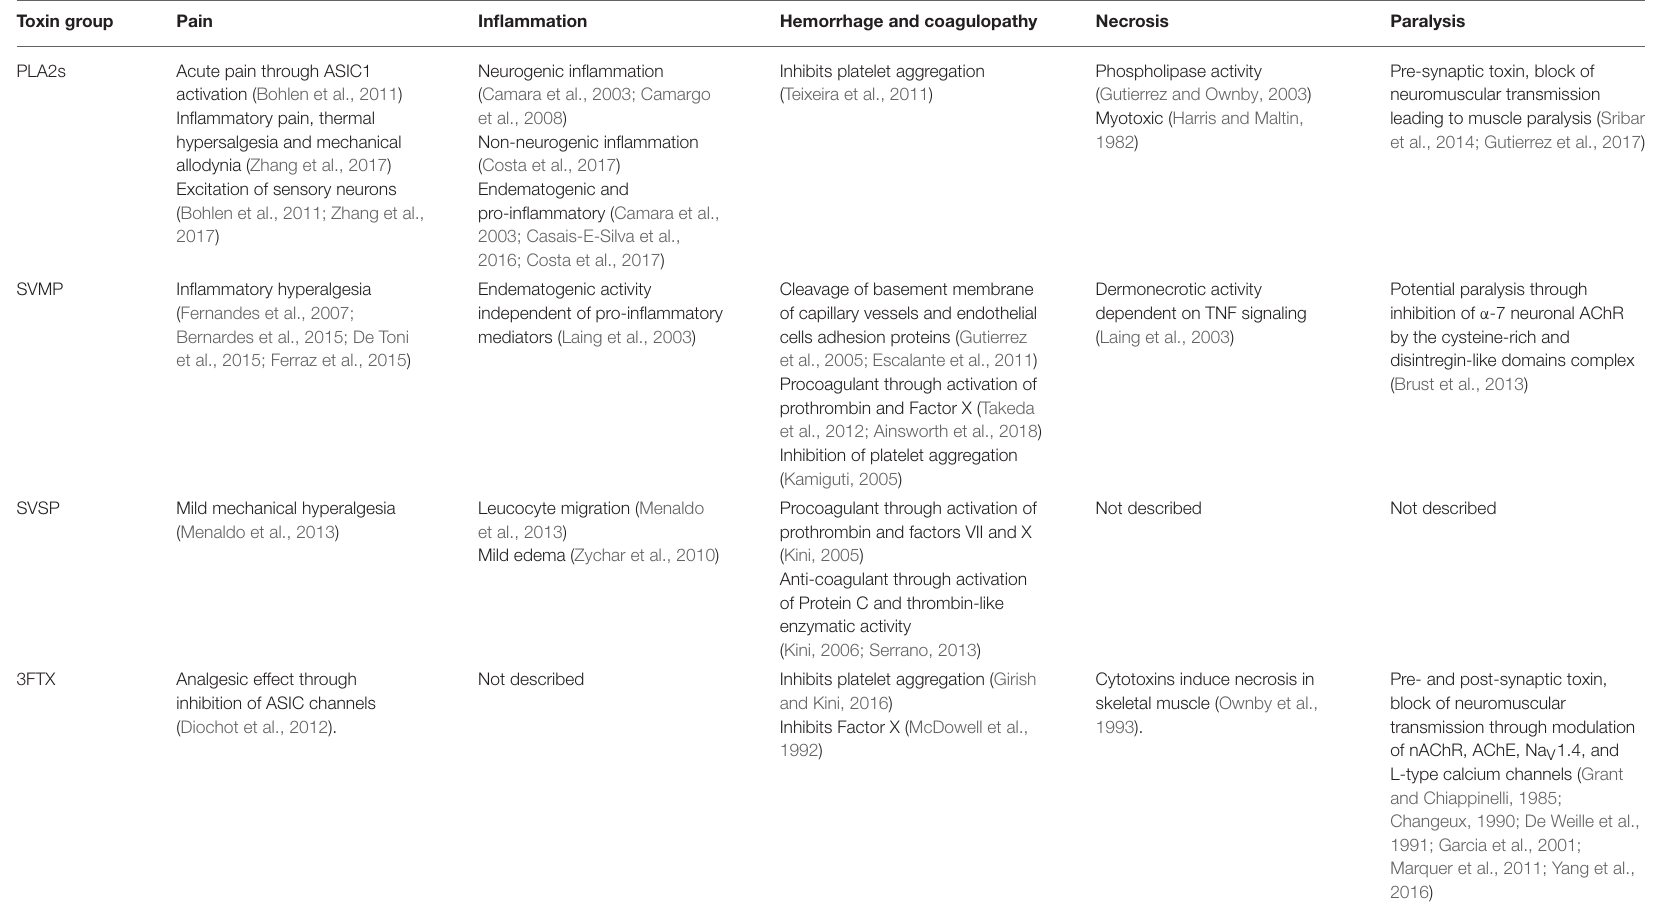
TABLE 1 | Snake toxins and their multifunctional roles in the toxicity induced by snakebites. Toxin group